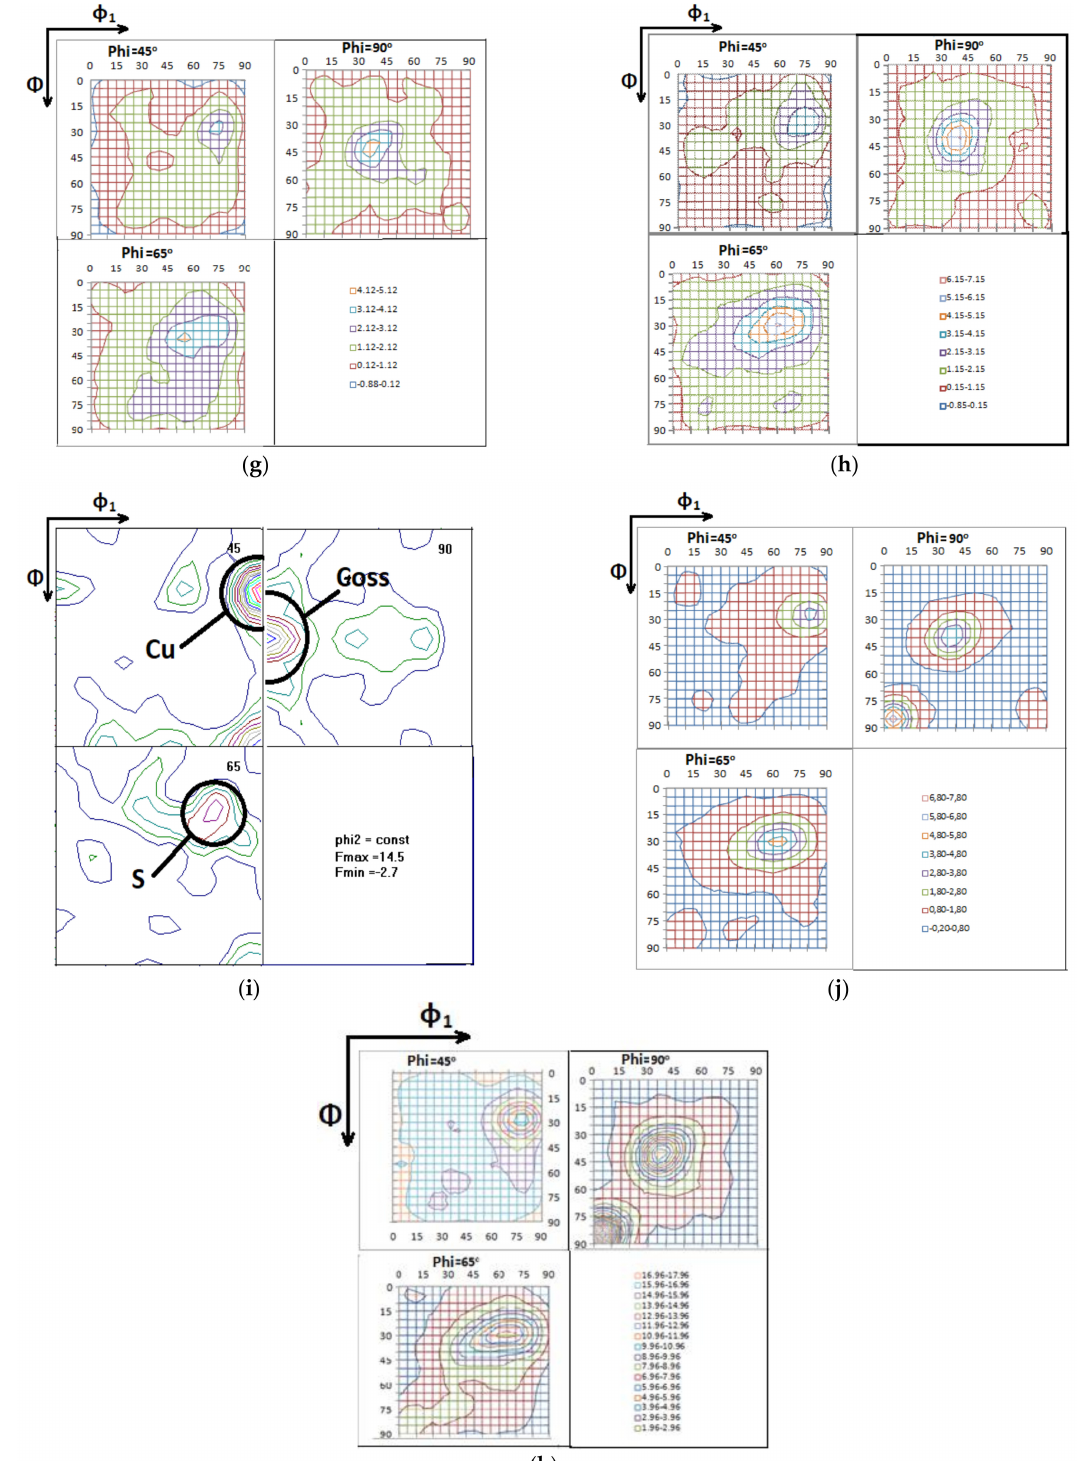
Figure 22. Calculation results for 1565ch alloy: ( a ) homogenization, ( b ) 29.82% deformation, ( c ) 29.82% deformation (modeling); holding at 29.82% deformation and elevated temperature: ( f ) experimental data. Calculation results for 8011 alloy: ( g ) taking fragmentation into account, ( h ) without regard to fragmentation of intermetallic compounds; ( d ) 80.70% deformation; ( e ) 80.70% deformation (modeling), ( i )-experimental data, ( j ) taking fragmentation into account, ( k ) without regard to fragmentation of intermetallic